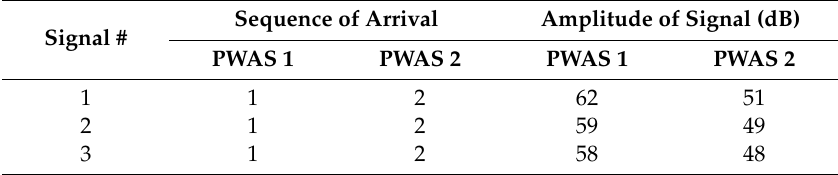
Figure 23. Typical AE signals captured during fatigue crack growth. Three sets of captured signals are presented. For each set, the signal at PWAS 1 and the corresponding signal at PWAS 2 are presented. The AE signals seem to maintain their signature at PWAS 1 and 2. Table 3. Sequence of arrival and amplitude of the AE signals at PWAS 1 and PWAS 2.